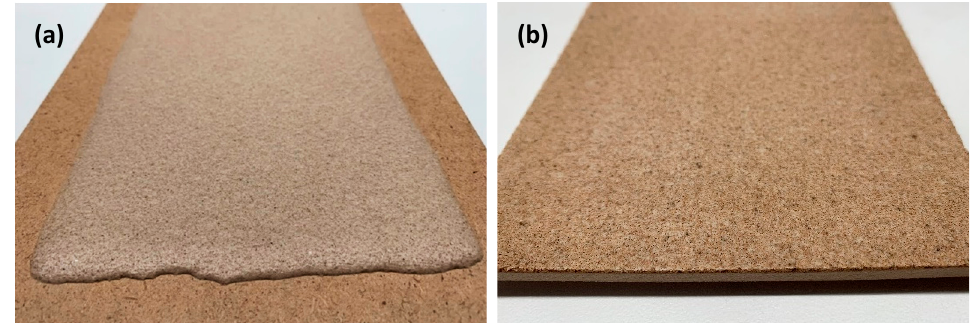
Figure 2. Photographic images of F11 composite coating applied on a 300 mm × 200 mm HDF substrate: ( a ) after drying; ( b ) after sanding the surface and trimming the borders.